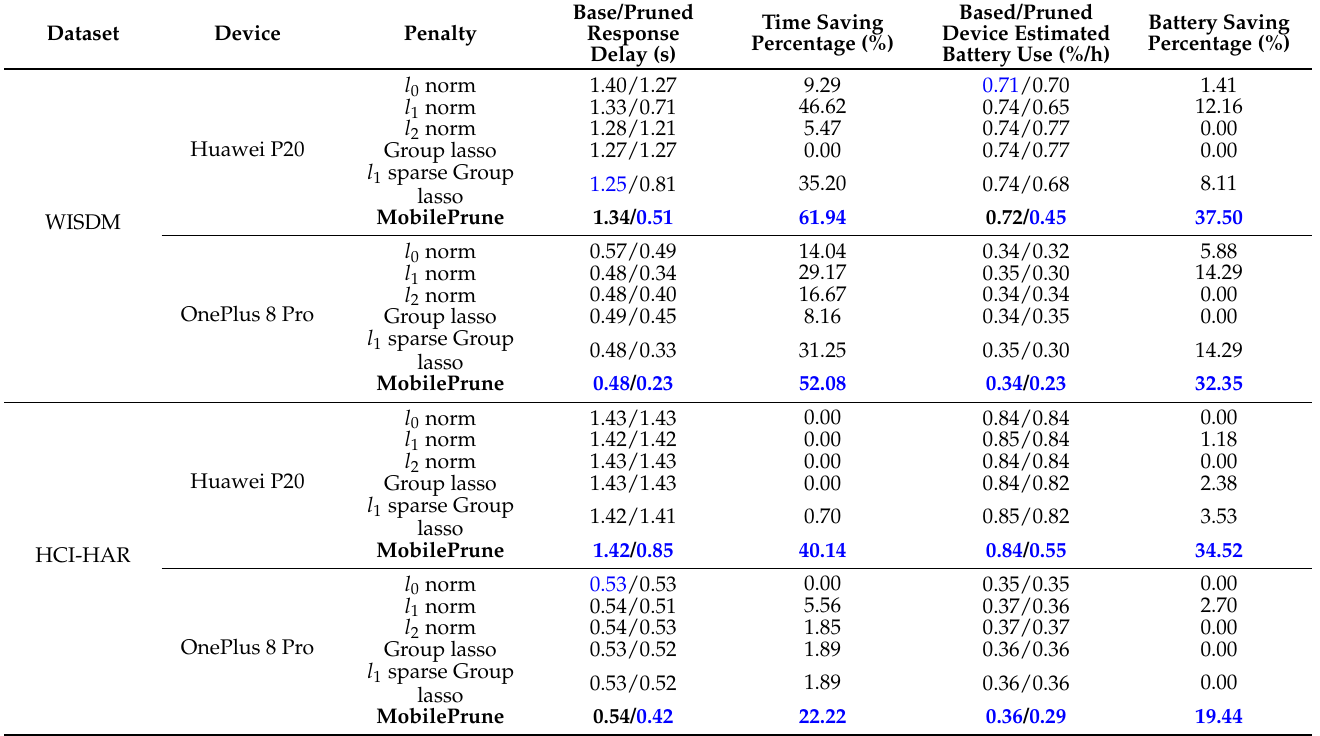
Table 3. Comparison of pruning method on the mobile devices with other state-of-the-art prun- ing methods for computational cost and battery usage on HAR dataset—WISDM, HCI-HAR, and PAMAP2, respectively. (We highlight our MobilePrune results and mark the best performance as blue among different penalties for each device in each